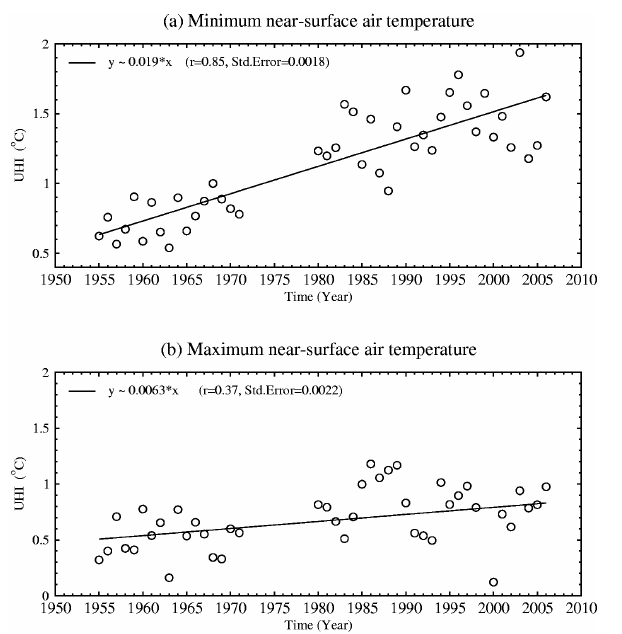
Figure 4. The summer-mean urban heat island (UHI) e ff ect on (a) minimum and (b) maximum near-surface air temperature estimated as the di ff erence between urban and rural ground-based weather sta- tions, with the linear trend, 1955–2006. r is the correlation coe ffi - cient and Std.Error is the standard error of the regression coe ffi cient (no data were found between 1972 and